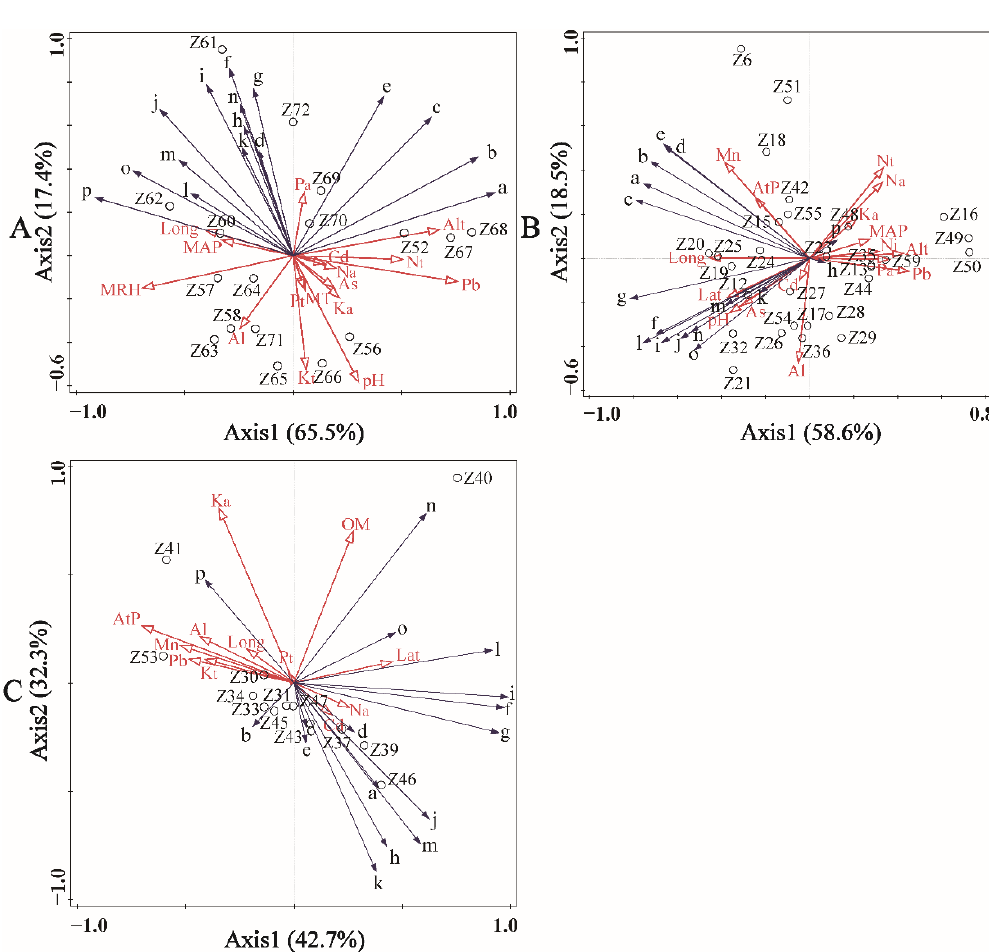
Figure 4. The relationships between environmental factors and volatile oil profiling in prickly ash pericarps: ( A ) ZA, ( B ) ZB1, ( C ) ZB2. ZA, samples with green pericarps ( n = 17) derived from species of Z, armatum ; ZB1, samples with red peri- carps represented by Hancheng ( n = 29) derived from species of Z. bungeanum ; ZB2, samples with red pericarps repre- sented by Fengxian ( n = 13) derived from species of Z. bungeanum ; Lat represents latitude of the plantation; Long represents longitude of the plantation; Alt represents altitude of the plantation; AtP represents mean atmospheric pressure of the plantation; MAP represents mean annual precipitation of the plantation; MRH represents mean relative humidity of the plantation; MT represents mean temperature of the plantation; pH represents power of hydrogen in the soil; OM repre- sents organic matter content in the soil; N t represents the total nitrogen content in the soil; P t represents the total phospho- rus content in the soil; K t represents the total potassium content in the soil; N a represents available nitrogen content in the soil; P a represents the available phosphorus content in the soil; K a represents the available phosphorus content in the soil; Al represents aluminum content in the soil; As represents arsenic content in the soil; Cd represents cadmium content in the soil; Mn represents manganese content in the soil; Ni represents nickel content in the soil; Pb represents lead content in the soil; a, sabinene; b, alfa-myrcene; c, D-limonene; d, alfa-pinene; e, alfa-ocimene; f, gamma-terpinene; g, terpinolene; h, linalool; i, terpinen-4-ol; j, terpineol; k, linalyl acetate; l, alfa-terpinyl acetate; m, geranyl acetate; n, caryophyllene; o, beta-elemene; p, nerolidol. 4. Discussion As a primary processing product, the volatile oils of prickly ash pericarps perform increasingly important roles in the food, pharmacological, and industrial fields [13]. The different content and compositions of volatile oils in prickly ash pericarps contribute to diverse flavors when used as spices and vary in bioactivity when used as functional food or pharmacological material. The content difference of volatile oils underlies different qualities and prices of pericarps. The difference in the content of volatile oils in prickly ash pericarps among different plantations and different groups (ZA, 6.02 mL/100 g; ZB1, 2.90 mL/100 g; ZB2, 4.60 mL/100 g; others, 2.26 mL/100 g) was reported in our previous article [9]. In this continuous research, a total of 47 constituents were detected in the